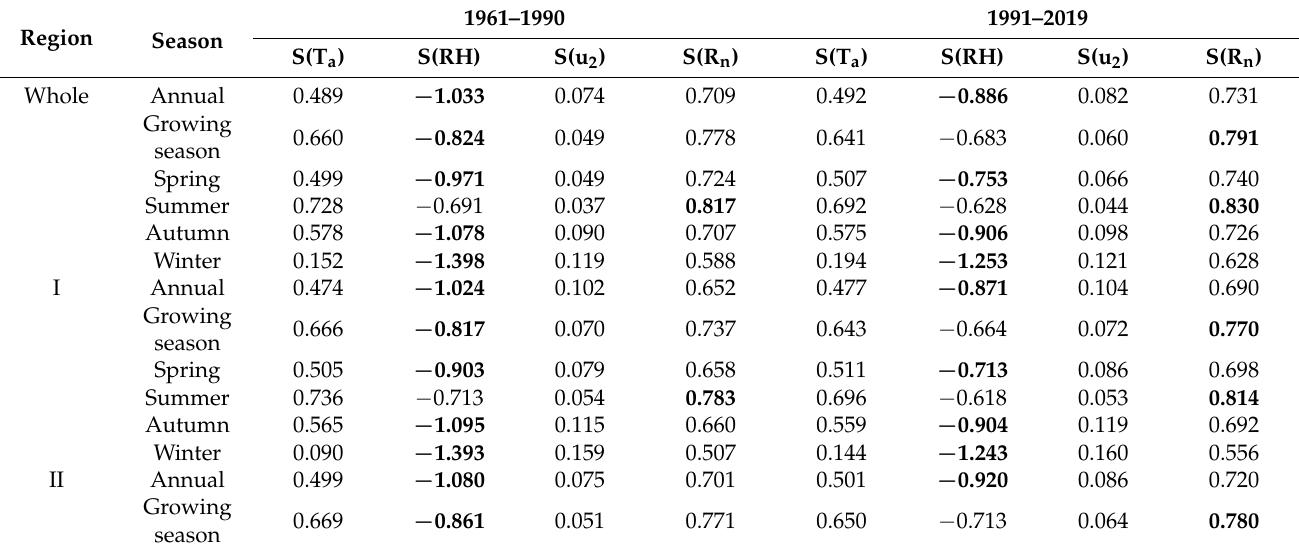
Table 3. Sensitivities of ET 0 to meteorological factors during 1961–1990 and 1991–2019.